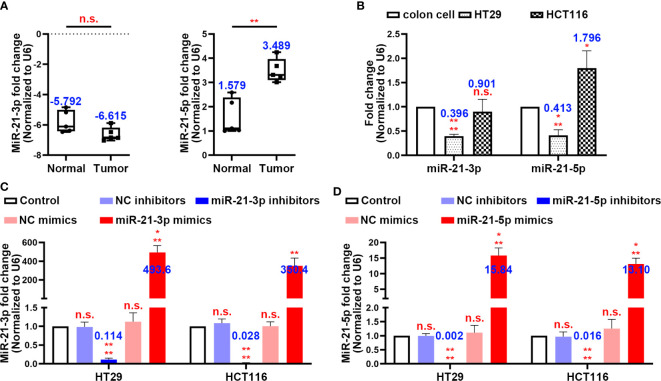
MiR-21-3p and miR-21-5p expression in colorectal cancer (CRC) and model establishment. (A) The expression levels of miR-21-3p and miR-21-5p in CRC patients’ tumours (n = 5) and normal tissues (n = 5). (B) The expression levels of miR-21-3p and miR-21-5p in normal colon cell, HT29, and HCT116. (C, D) Validation of miR-21-3p mimics/inhibitors (C) and miR-21-5p mimics/inhibitors (D) efficiency in HT29 and HCT116 cells as determined by qRT-PCR. The bars and error bars indicate the mean ± SD. n.s.p > 0.05, *p < 0.05, **p < 0.01, ***p < 0.005, ****p < 0.001.